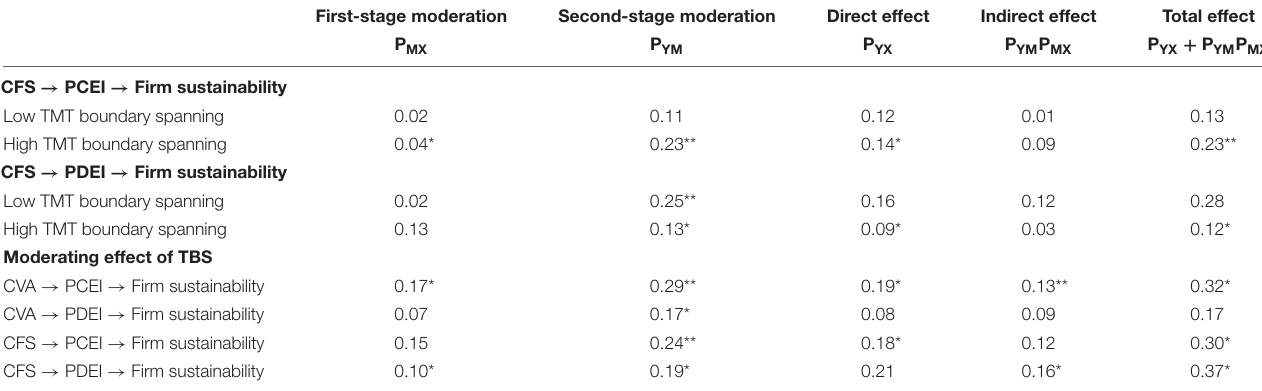
TABLE 4 | Bootstrapping-based moderated path